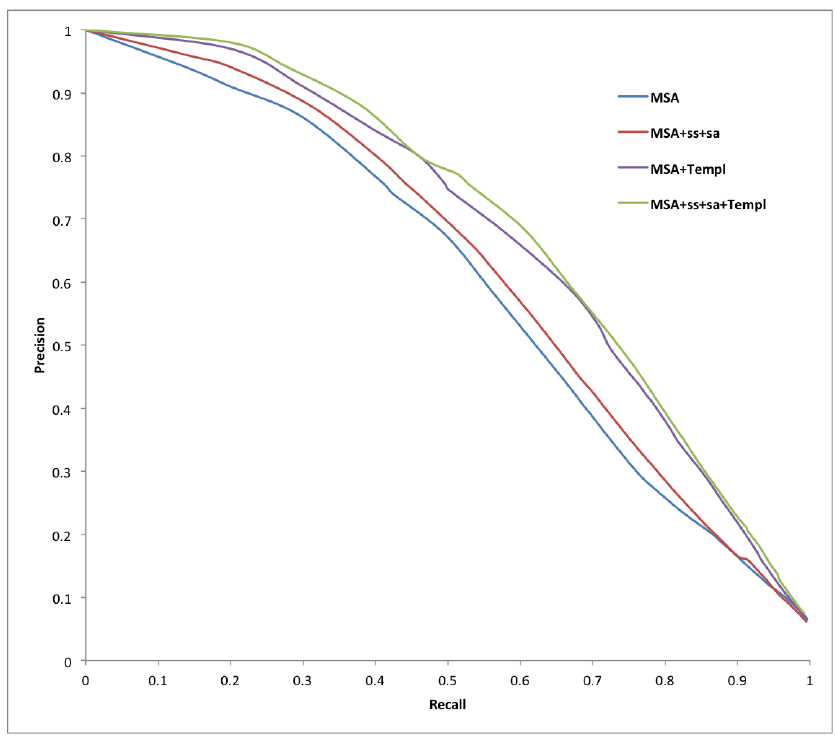
Figure 2. Precision-recall curves for all of our systems on X-ray test set